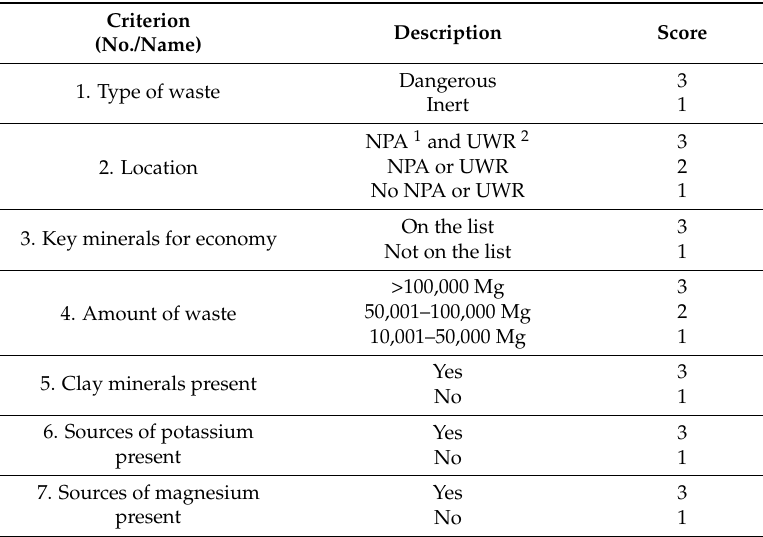
Table 1. Scoring scale for each of the 7